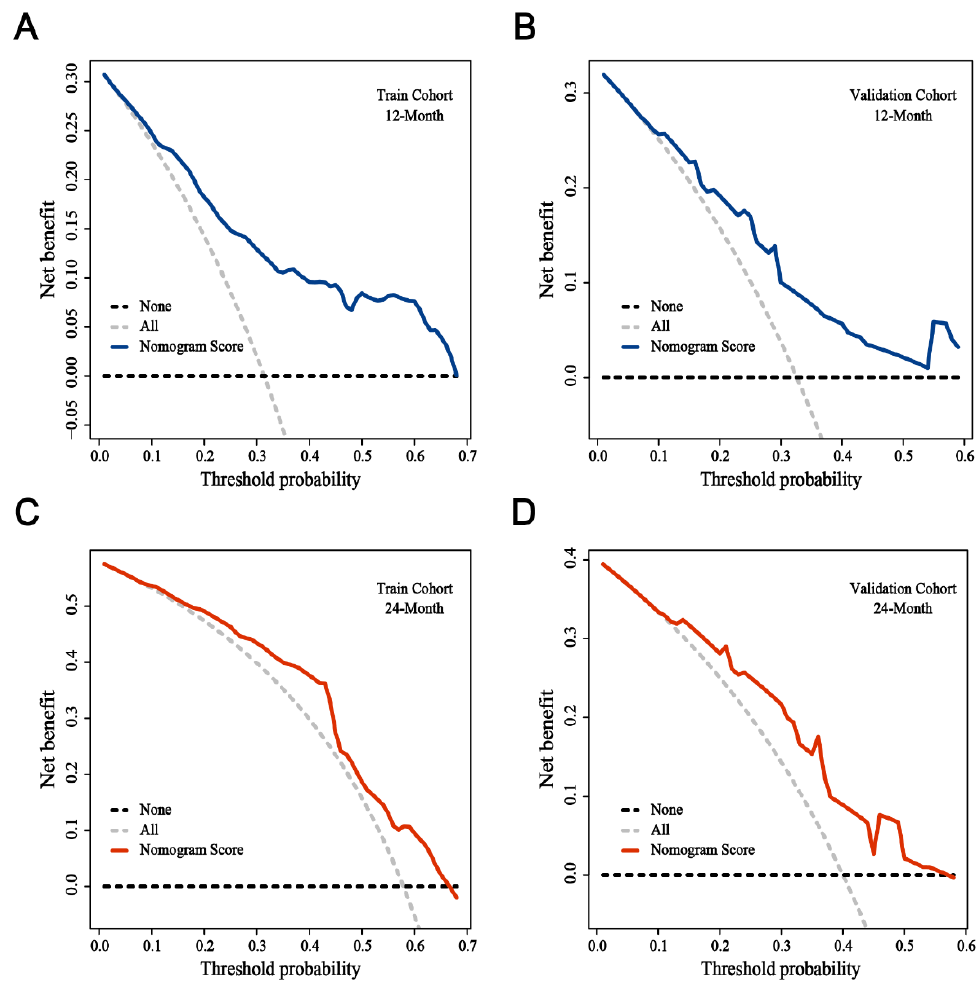
Figure 6. Decision curve analysis for the nomogram in training ( A , C ) and validation cohort ( B , D ).